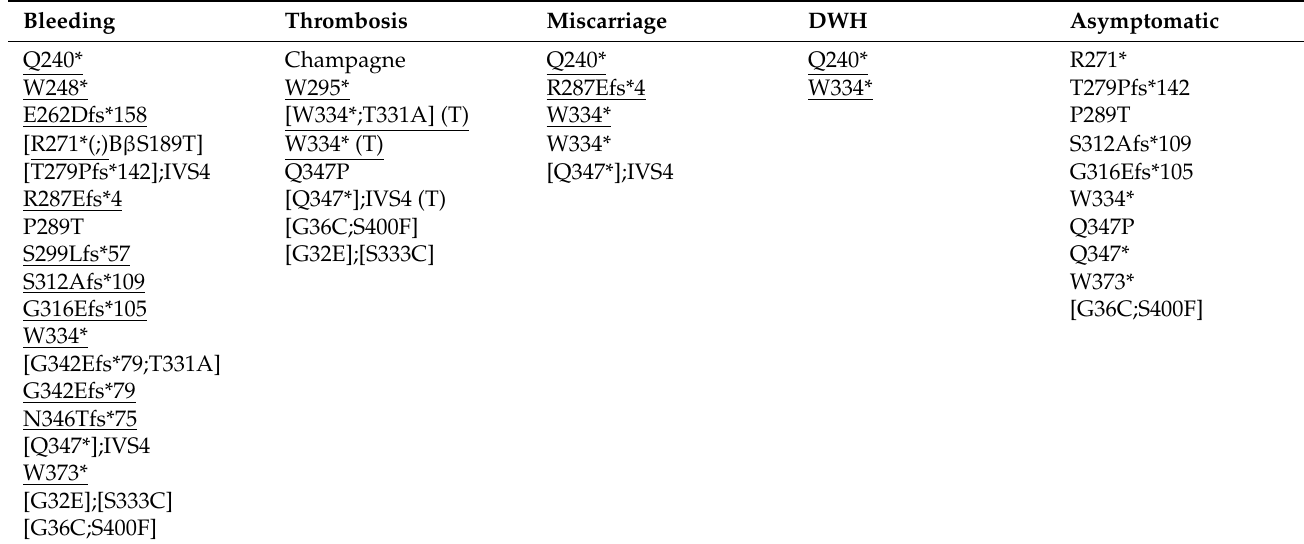
Table 3. Mutations in the α C-connector of fibrinogen assigned to their clinical manifestations. The positions within the nascent protein chain are used. Homozygous mutations are underlined. Champagne = complex fibrinogen Champagne au Mont d’Or; IVS4 = intronic mutation g.510+1G>T; DWH = delayed wound healing; T = state after